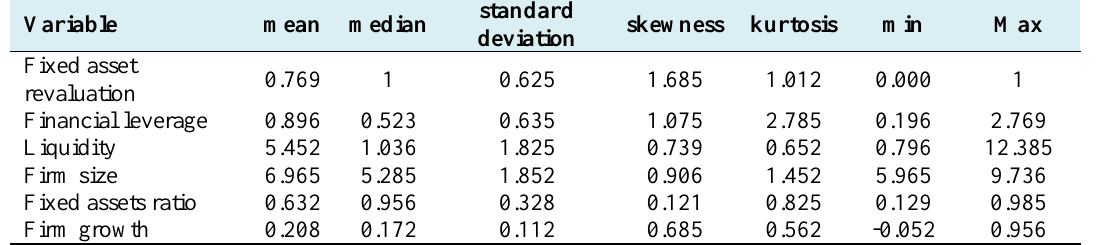
Table 3. Descriptive statistics of research variables of companies listed on the BSE during